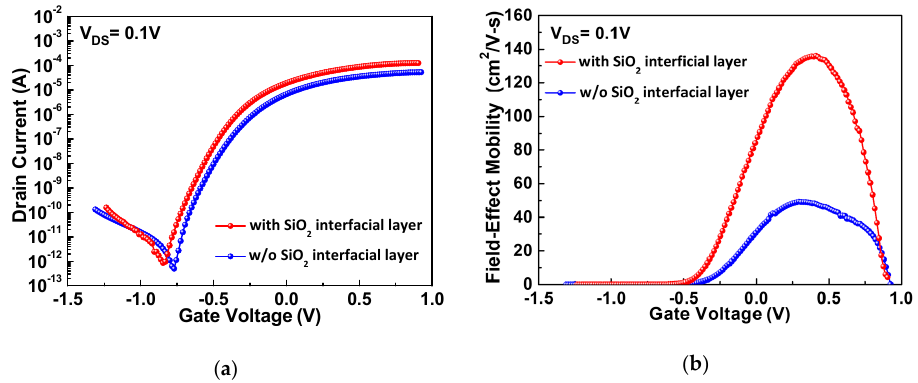
Figure 1. ( a ) I DS -V GS and ( b ) µ FE -V GS characteristics of the top-gate SnO 2 TFTs with and without an SiO 2 interfacial layer.